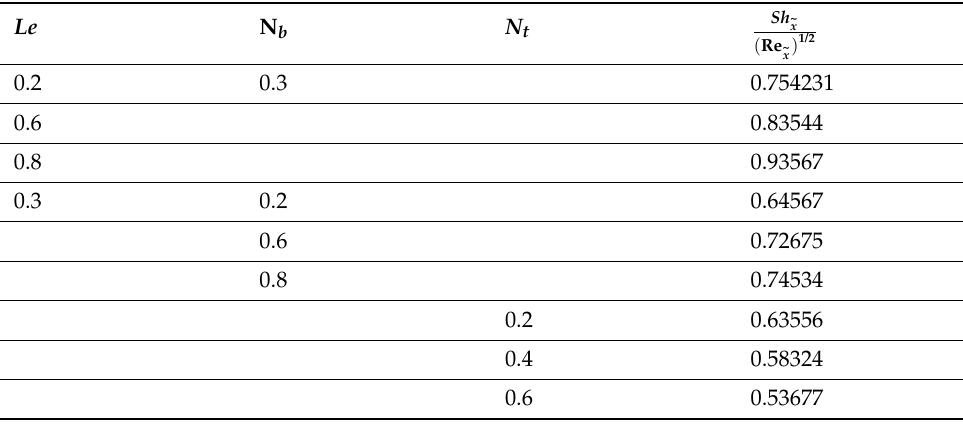
Table 2. Evaluation of Sherwood number at various governing